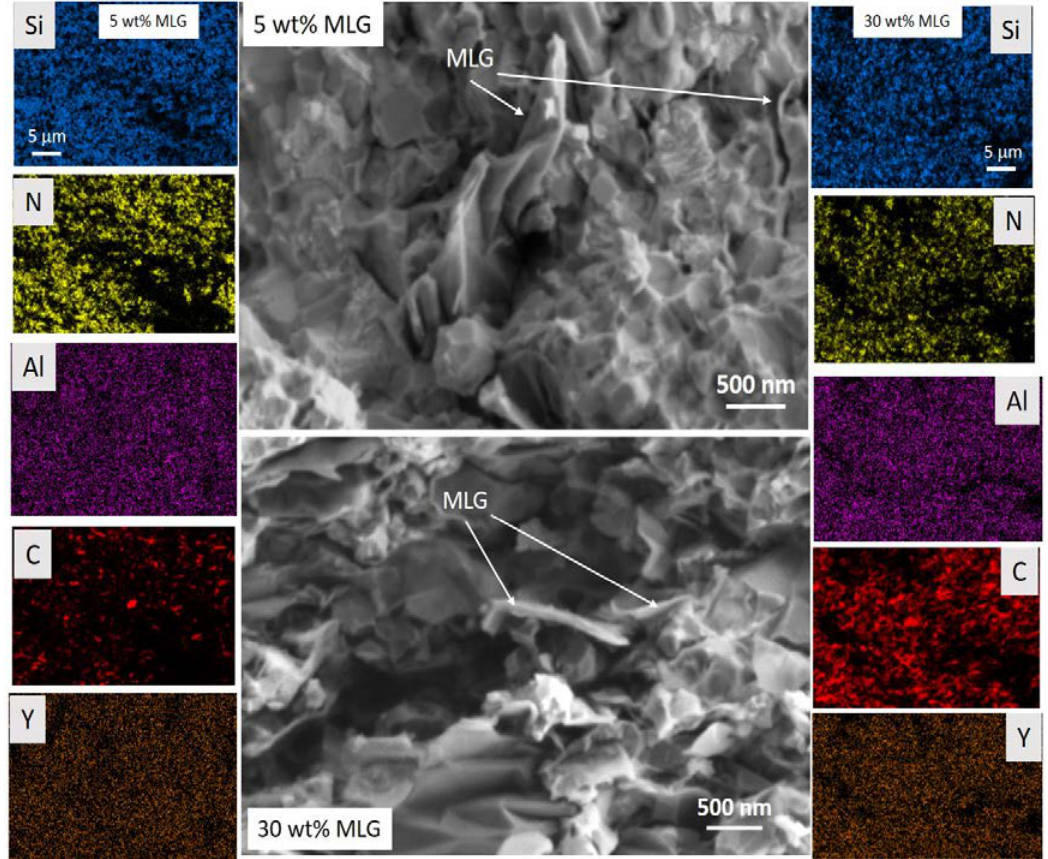
Figure 6. Structural observations of multilayered graphene (MLG) added Si 3 N 4 composites with elemental maps of Si, N, Al, C and Y elements.